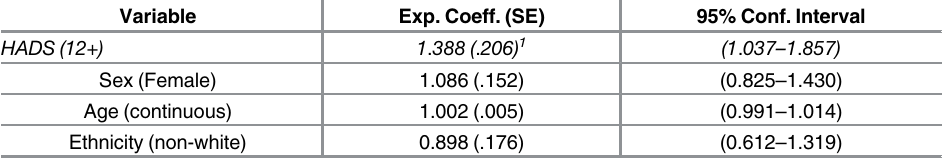
Table 5. Impact on total health care costs of people scoring above the cut-off (12+) on HADS at initial assessment.